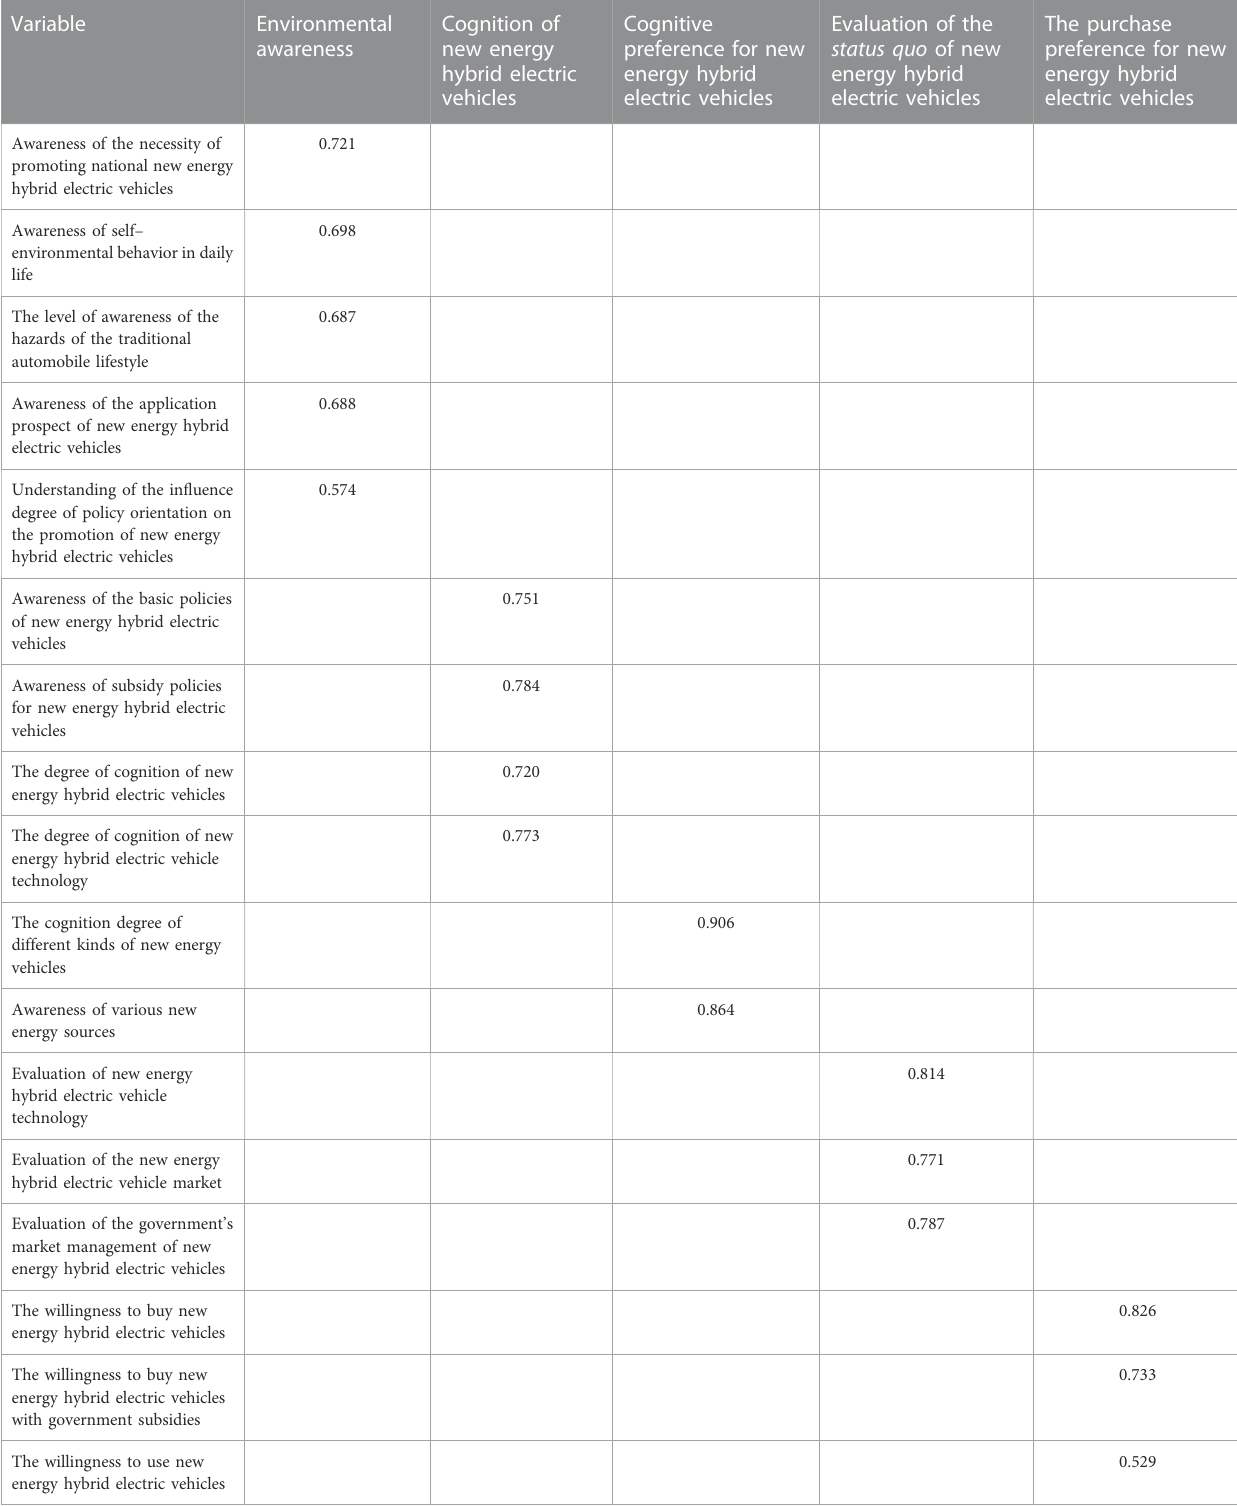
TABLE 4 Factor load matrix of 17 variables after orthogonal